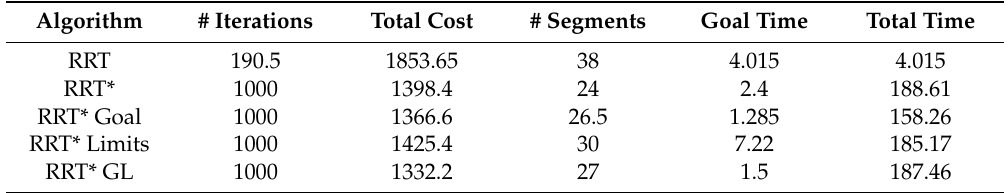
Table 9. Results. Two obstacles, 1000